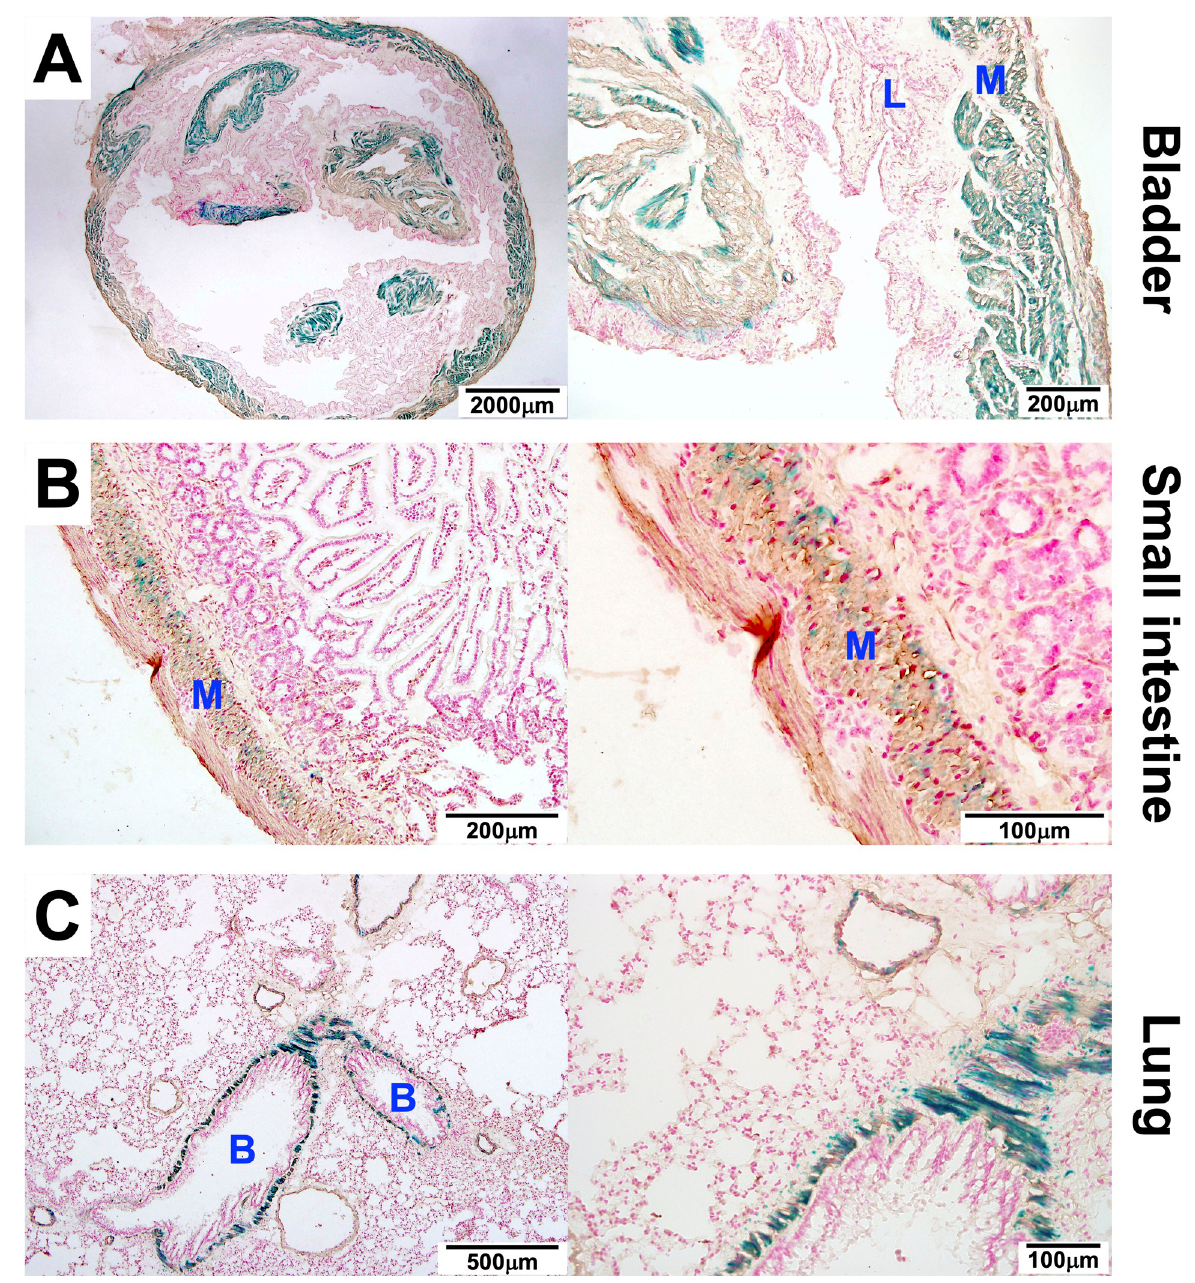
Fig 5. MYL9 is highly expressed in the muscularis propria of the bladder and intestine, and in the bronchial smooth muscle layer. Sections of the (A) bladder, (B) small intestine and (C) lung from a representative Myl9 -/+ mouse was stained with X-gal to detect Myl9 promoter activity and an anti- α -SMA antibody (brown stain) to identify smooth muscle. The sections were counterstained with nuclear fast red. Low and high magnification images are shown. M = muscularis propria; L = lamina propria; S = serosa; B = bronchus. compound heterozygous loss of function mutations [25]. Bronchopulmonary dysplasia was also observed in one of these patients [25]. These phenotypes in the intestine, bladder and lung are consistent with those seen in Myl9 -/- mice. This confirms that MMIHS can indeed be caused by mutations in the MYL9 gene. This also suggests that intestine and bladder